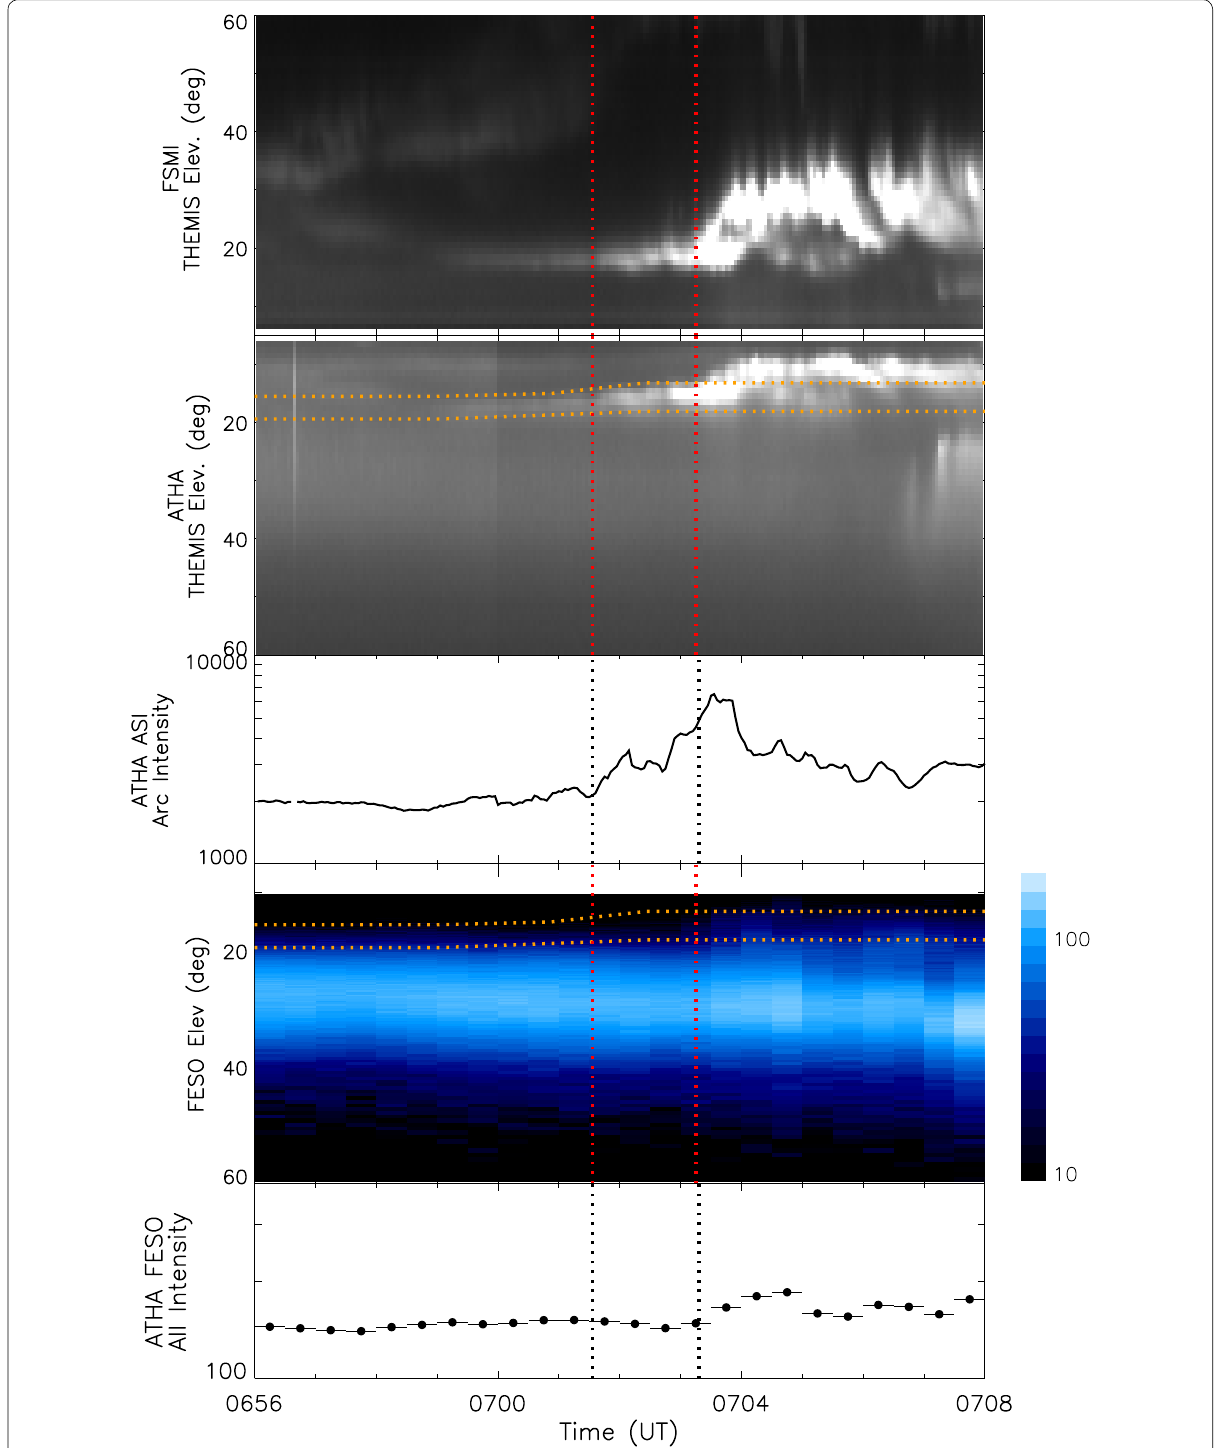
Fig. 7 THEMIS ASI observations and FESO proton auroral observations. The top two panels show the FSMI ASI keogram and ATHA ASI keogram constructed along the FESO meridian, respectively. The arc band is shown in orange dotted lines in the 2nd panel. The 3rd panel shows the ATHA ASI counts sampled and averaged over the arc band. The 4th panel shows the FESO proton auroral intensities versus time and latitude. The bottom panel shows the total proton auroral intensities integrated over full FESO latitudes. Two vertical dotted line throughout the plot denote T 0 and T 1, the TSSO